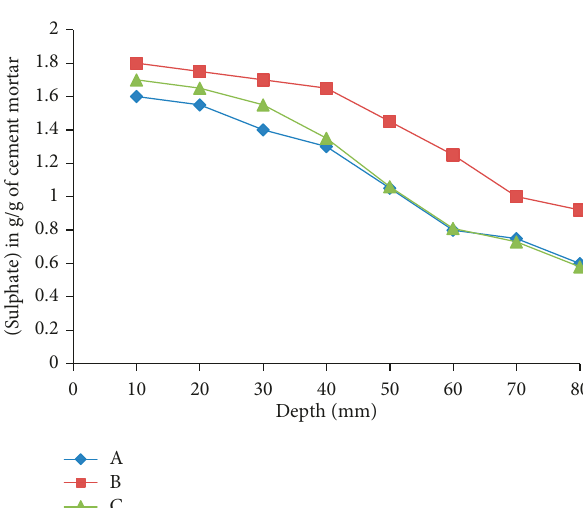
Figure 21: Sulphate profiles at w/c 0.6.